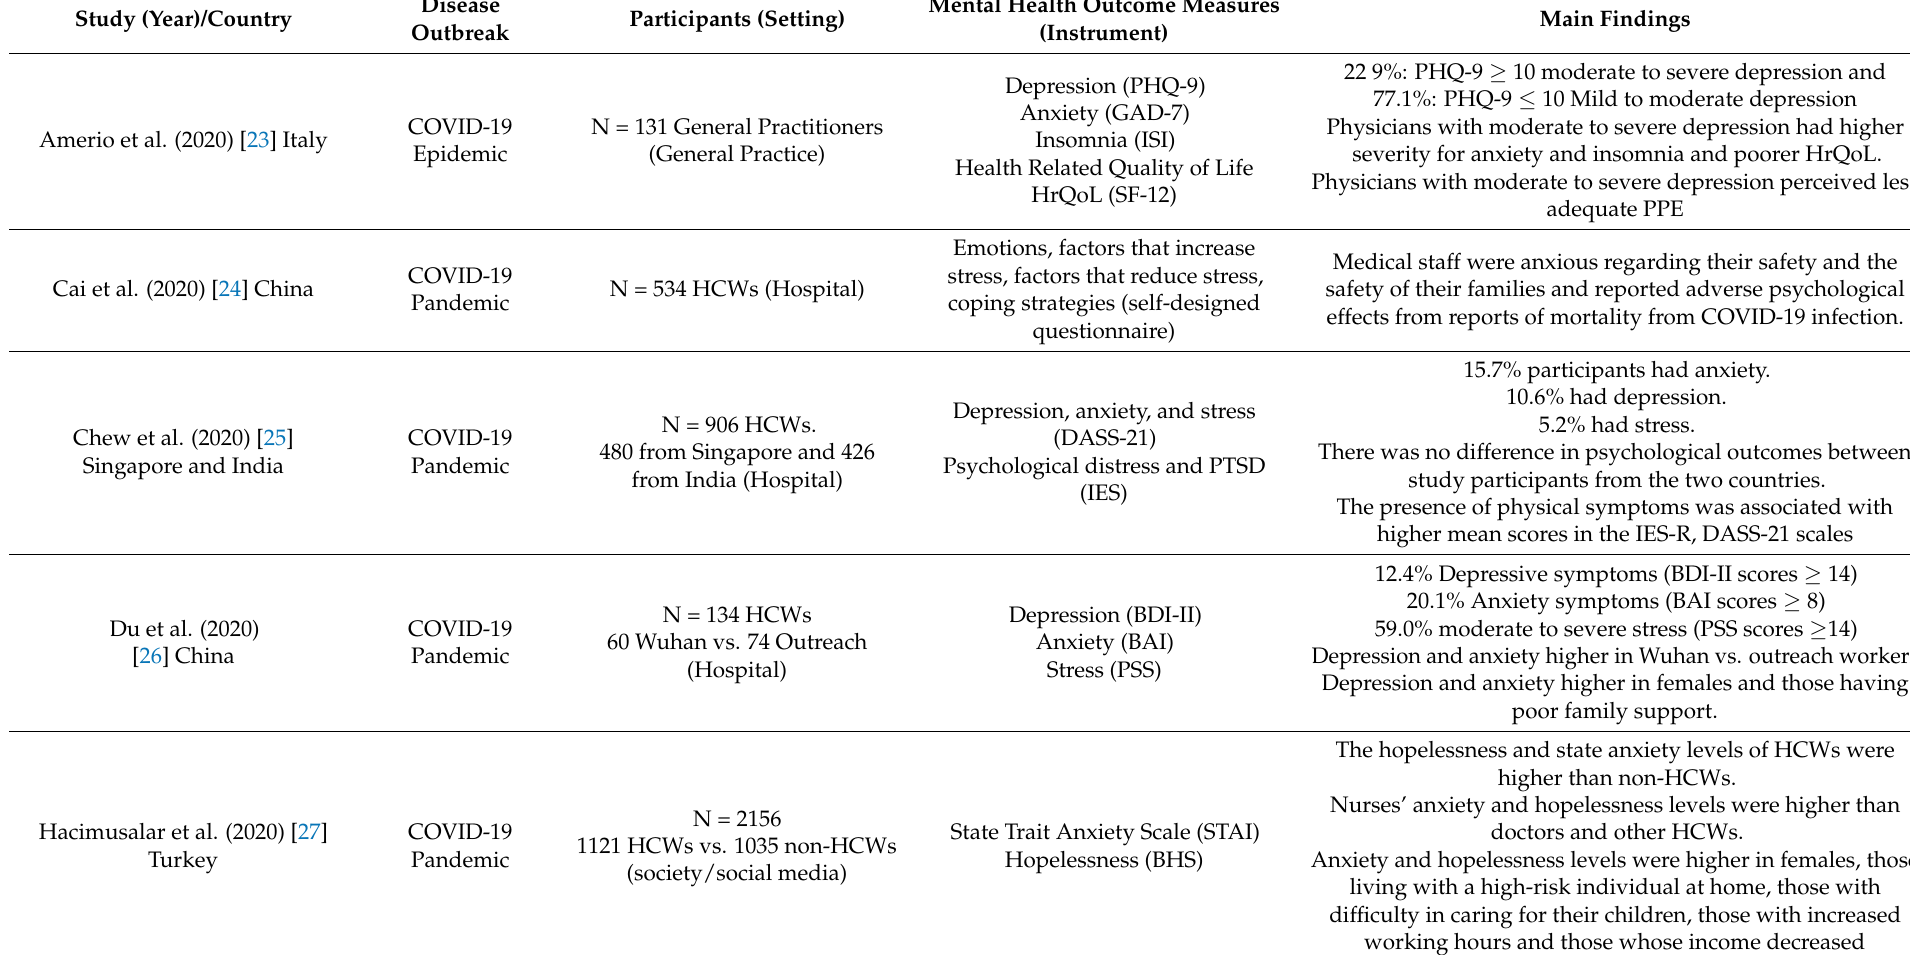
Table 1. A summary of the cross-sectional studies included in this